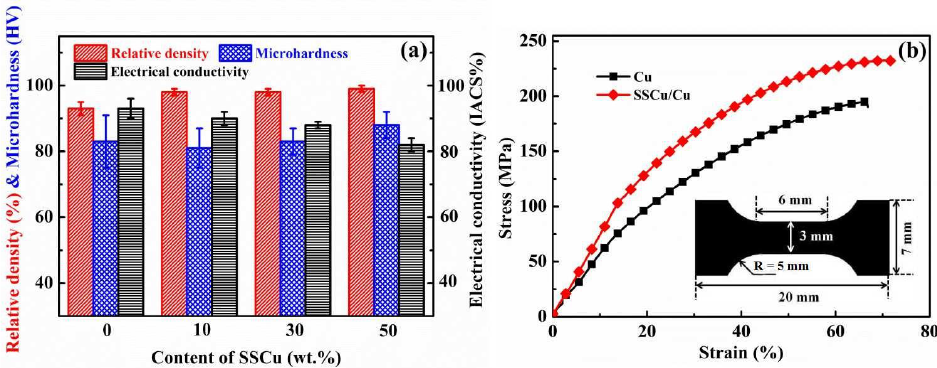
Figure 6. Comparison of the performance of SSCu/Cu with different SSCu contents: ( a ) relative density (RD), microhardness, and conductivity; ( b ) stress – strain curves.